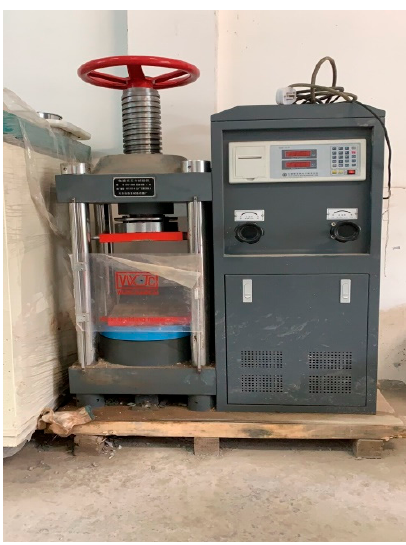
Table 2. The experimental scheme for each curing age and curing agent content.